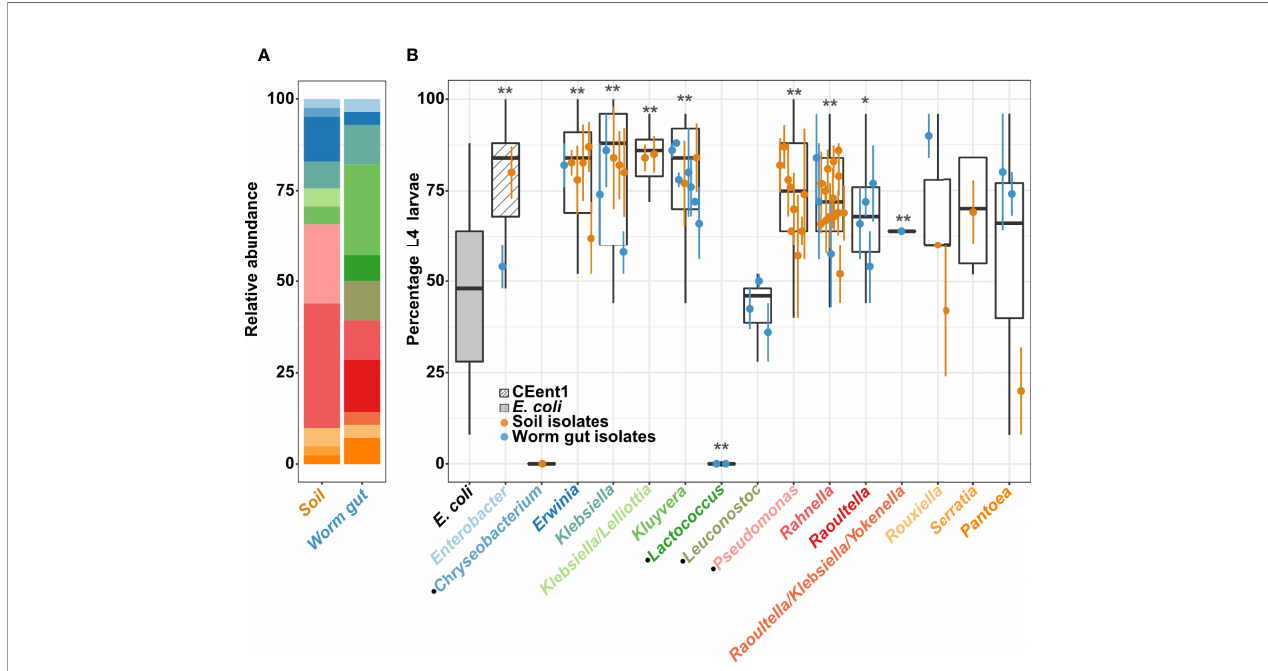
FIGURE 1 | Effects of environmental and worm gut isolates on C. elegans development. (A) Bacterial isolates distribution. Relative abundance of genera recovered from soil microcosms and from worm guts, identi fi ed based on full length 16S Sanger sequencing and colored as in panel B x -axis (see also Supplementary Table 1 ). (B) Percentage of L4 larvae in worm populations raised from eggs for 40 hours at 25°C on environmental or gut bacterial isolates, as designated, grouped at the genus level; N=25/strain/ experiment, dots represent averages (± SE) of 2 independent experiments. E. coli strain OP50 and Enterobacter hormaechei strain CEent1, in the gray and the hatched box, respectively, represent values from 41 experiments and provide reference for comparisons. Dotted lines represent the mean value for development on OP50, mean + SD and mean + 2 SD ’ s. Boxes extend from fi rst to third quartiles, with black lines representing the median. * p < 0.05; ** p < 0.001, in comparison to E. coli (Student ’ s t-test, corrected for multiple testing using Bonferroni). Black dots at x -axis labels indicate non-Enterobacteriales